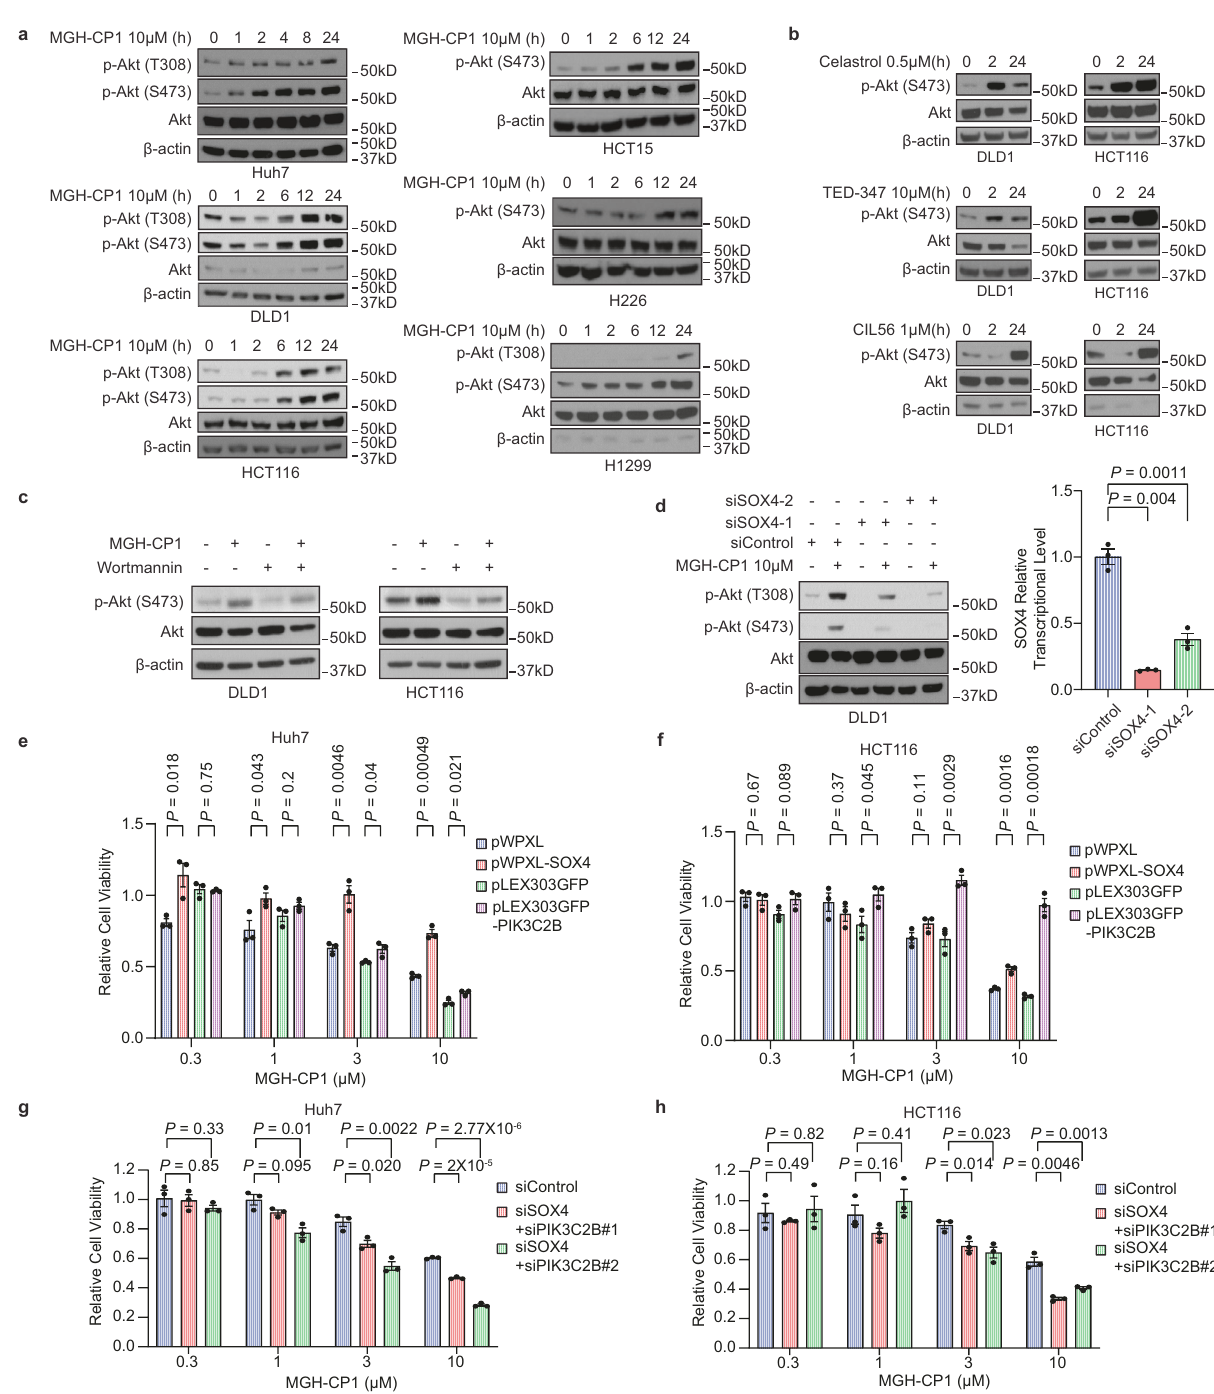
by MGH-CP1 treatment for 24h, p-AKT (T308), p-AKT (S473) and total AKT were examined by immunoblot. SOX4 expression levels were evaluated by qPCR after SOX4 siRNA knockdown ( n =3 biological repeats). Huh7 ( e ) and HCT116 ( f ) cells were overexpressed with SOX4 or PIK3C2B in the presence of MGH-CP1. Cell via- bilitywasshownatdifferentconcentrations( n =3biologicalrepeats).Huh7( g )and HCT116 ( h ) cells were treated with control siRNA and SOX4/PIK3C2B siRNA. Cell viability with treatment of different concentration of MGH-CP1was determined ( n =3 biological repeats). Data are represented as mean±S.E.M. P values were determinedusing two-tailed t -tests.Source data are provided asa Source Data fi